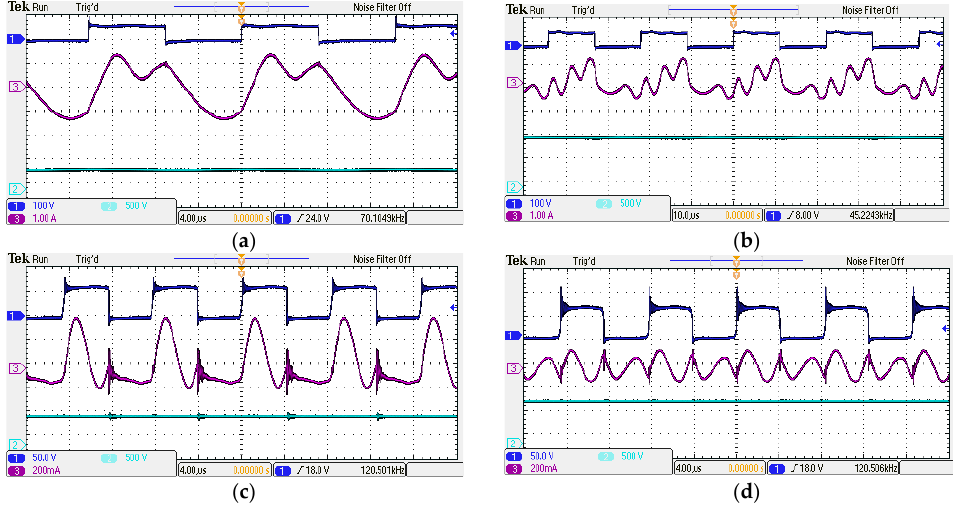
Figure 15. The LLC resonant converter with TR1 (1) V AB as blue, (2) I R as purple, (3) V OUT as turquoise: ( a ) full load at the resonant frequency f SW = 70 kHz; ( b ) light load at below resonant frequency f SW = 45 kHz; ( c ) light load at the above resonant frequency f SW = 150 kHz (ZVS loss); ( d ) open circuit at the above resonant frequency f SW = 120 kHz ZVS loss.